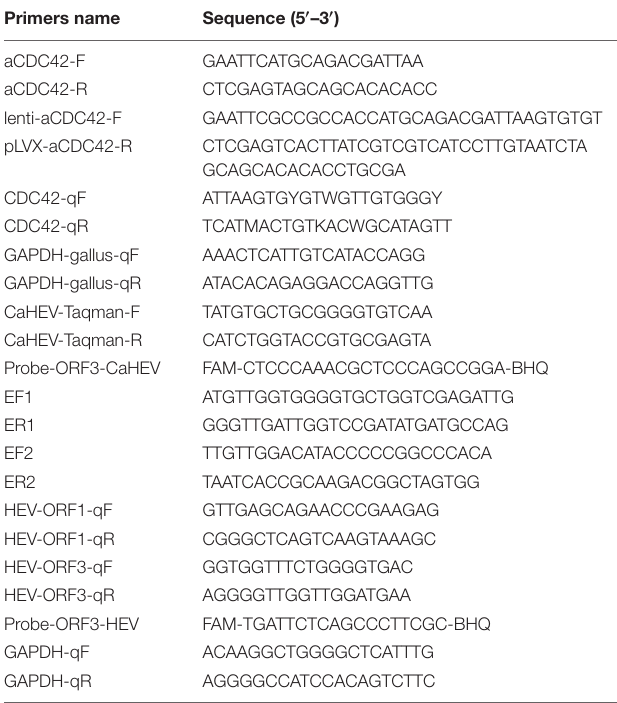
TABLE 1 | Primers used in gene expression